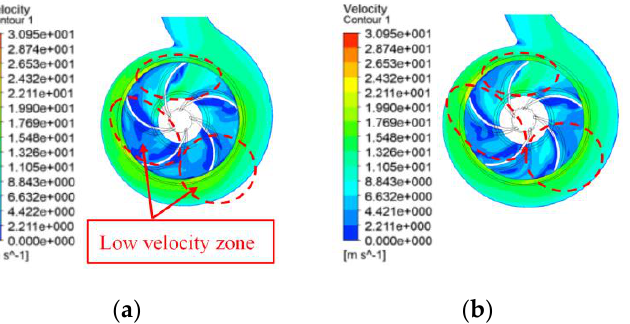
Figure 12. Pressure contours of flow region at 1250 rpm. ( a ) Original model; ( b ) rounded model.